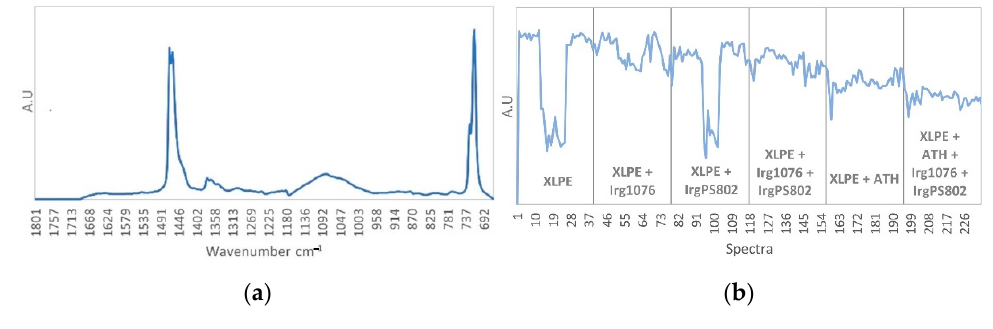
Figure 16. ( a ) XLPE pure spectrum. ( b ) XLPE concentration profile.